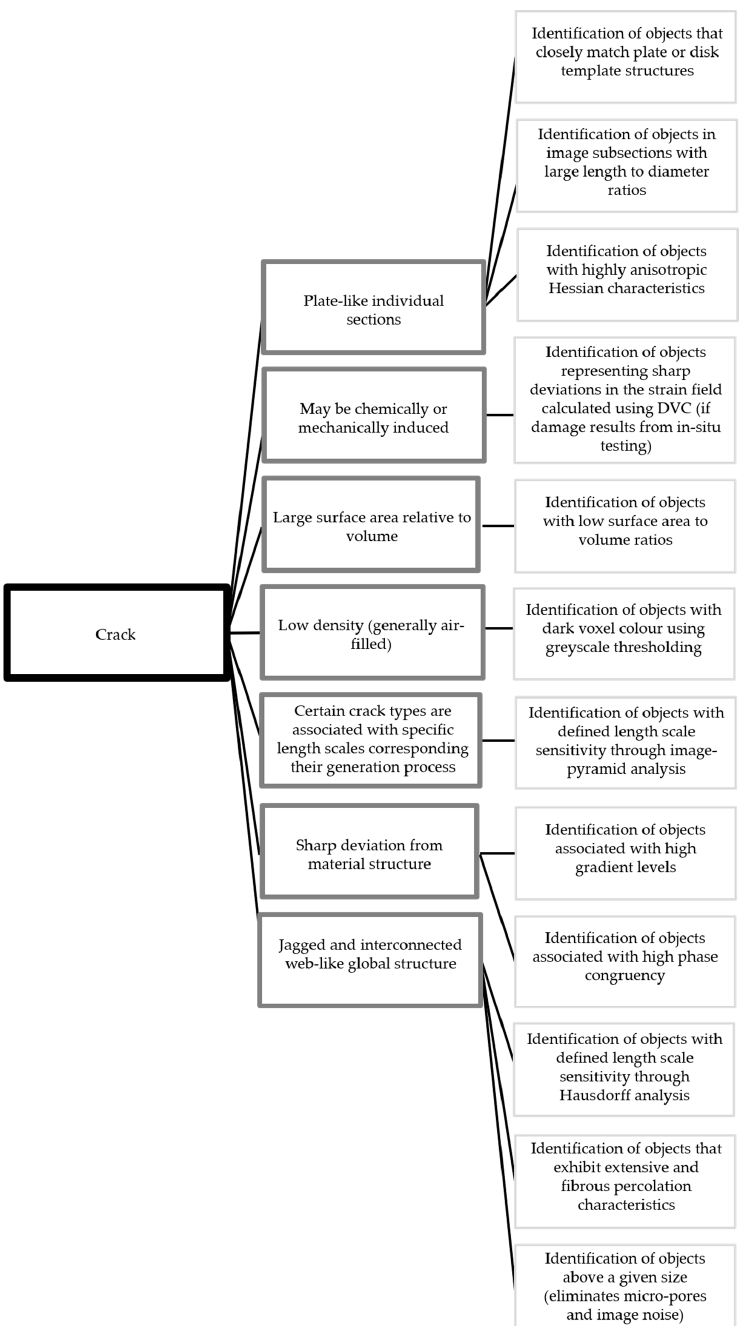
Figure 2. Virtual data fusion web linking cracks (black) with their characteristics (dark grey) and image analysis techniques for identifying objects with those characteristics (light grey).